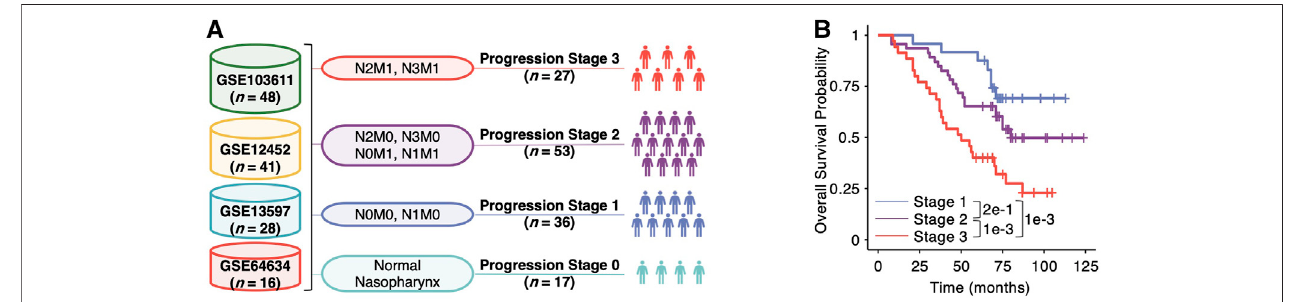
FIGURE 1 | Analytic framework of multiscale transcriptomic integration for nasopharyngeal carcinoma (NPC) progression. (A) Schematic view of multi-center microarray data integration. The number n in the brackets denotes the sample size of each dataset. The lymph node spread (N0, N1, N2 and N3) and overt metastasis (M0 and M1) in the TNM system are used in the staging step. (B) Kaplan-Meier plot of NPC patients in Stage one, two and three of the integrated cohort. Pairwise p values between two different stages are derived from two-sided log-rank